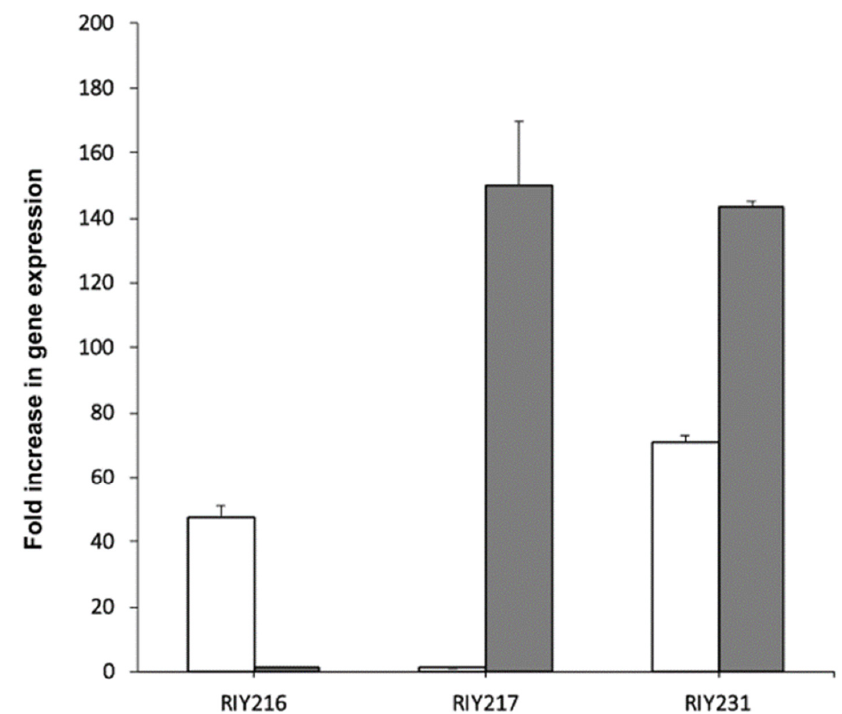
Figure 1. Transcriptional analysis of the genes ylGSH1 and ylGSH2 in strains RIY216 (p TEF - ylGSH1 ), RIY217 (p TEF - ylGSH2 ) and RIY231 (p TEF - ylGSH1 - ylGSH2 ). Strains were grown in YPD for 24 h. Data are the mean and standard deviation of triplicate experiments. Values are expressed as the fold difference compared to the corresponding expression level in wild-type strain JMY2900. The gene ylGSH1 is shown in white and ylGSH2 in light grey.